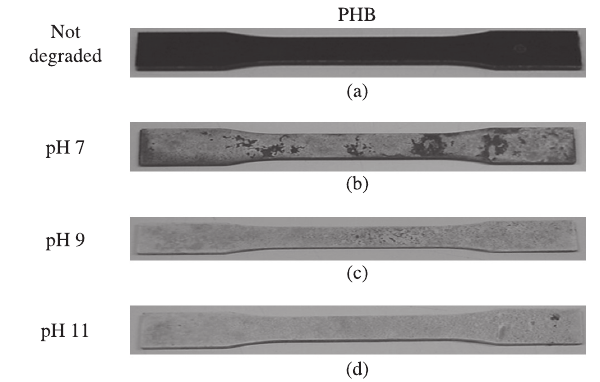
Figure 7. Photographs of the PHB specimens: a) before degradation tests, and after degradation tests in soil with varying pH; b) pH 7; c) pH 9; and d) pH 11.